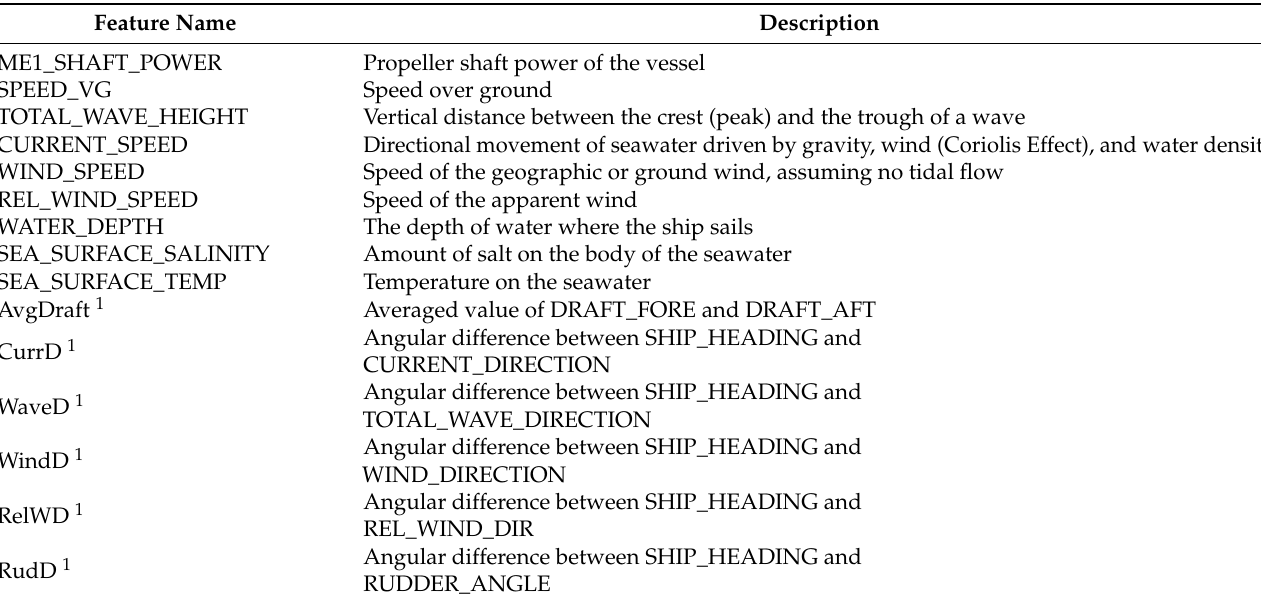
Table 6. Feature list after preprocessing.